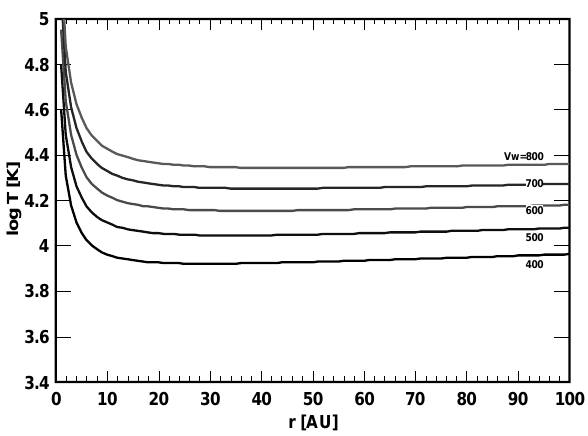
Fig. 2. Shown versus solar distance r along the upwind axis is the temperature T 1 of primary solar wind ions in units of [Kelvin] for various solar wind bulk speeds V w . Consistent with the variation of V w , solar wind density, the Alfv´en speed and the energy input parameters g 0 and G 0 have also been changed according to pre- scriptions derived in the